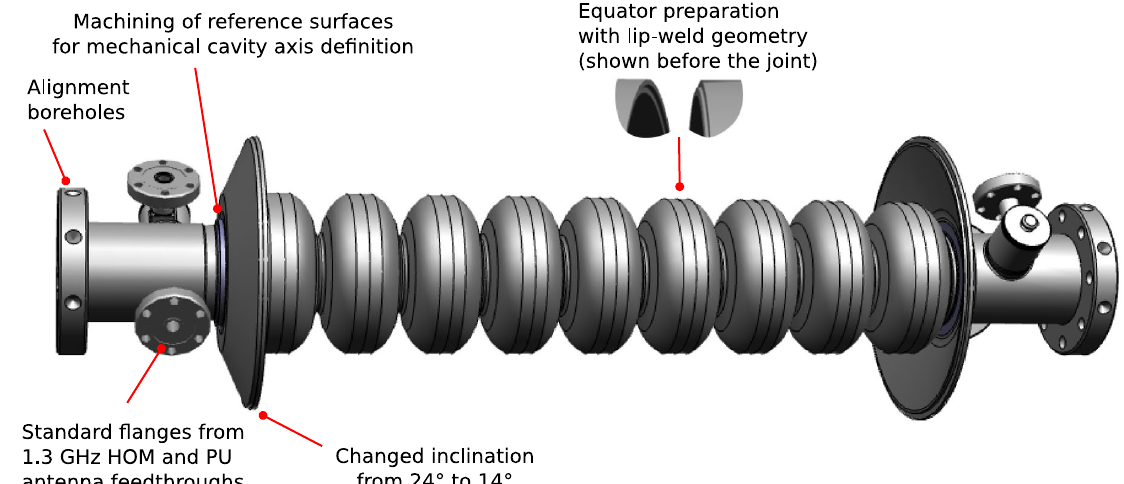
FIG. 1. Summary of the 3.9 GHz EXFEL cavity mechanical